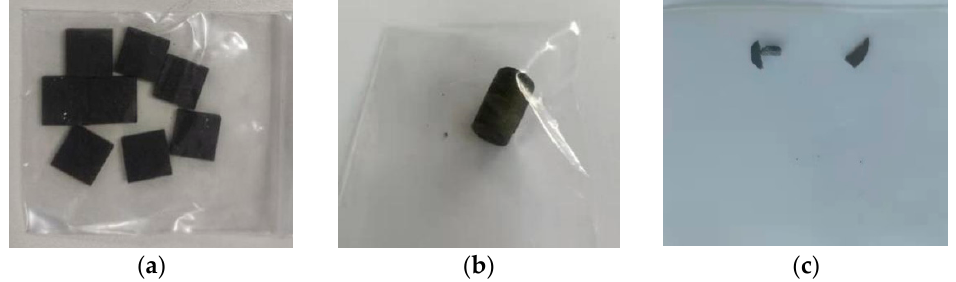
Figure 7. The experimental specimens. ( a ) 10 mm × 10 mm × 3 mm. Specimen used for SEM (Gemini 300 scanning electron microscope), XRD (X’ Pert Powder diffractometer), and hardness testing (HV-1000 microhardness tester). Specimen was polished and inlaid with resin. Initial cooling ( c ) Specimen used for PSD (Setaram Setsys Eco Synchronous thermal analyzer).